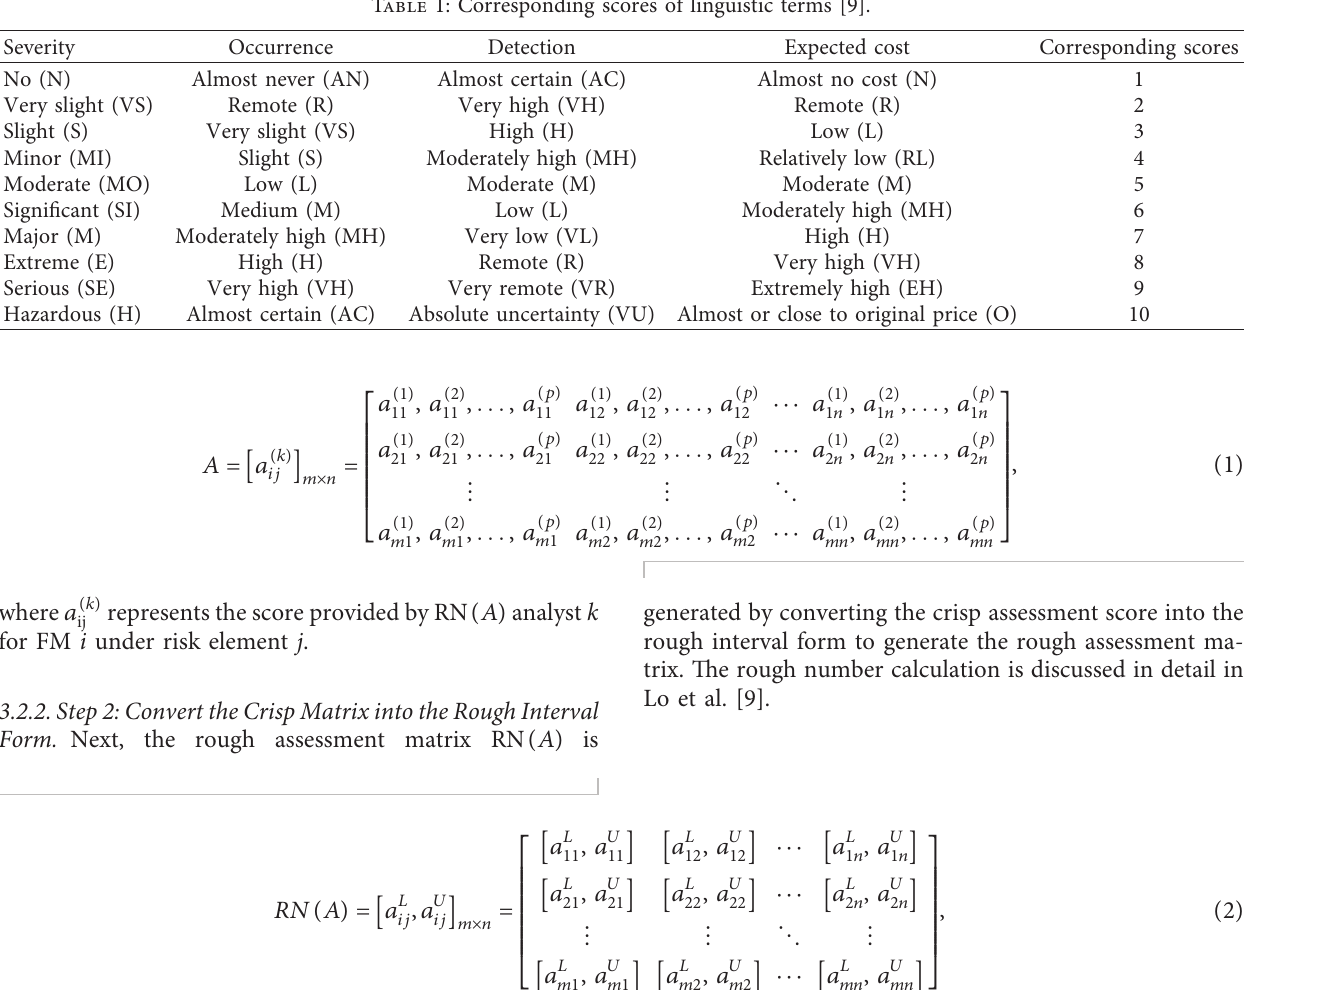
Table 1: Corresponding scores of linguistic terms